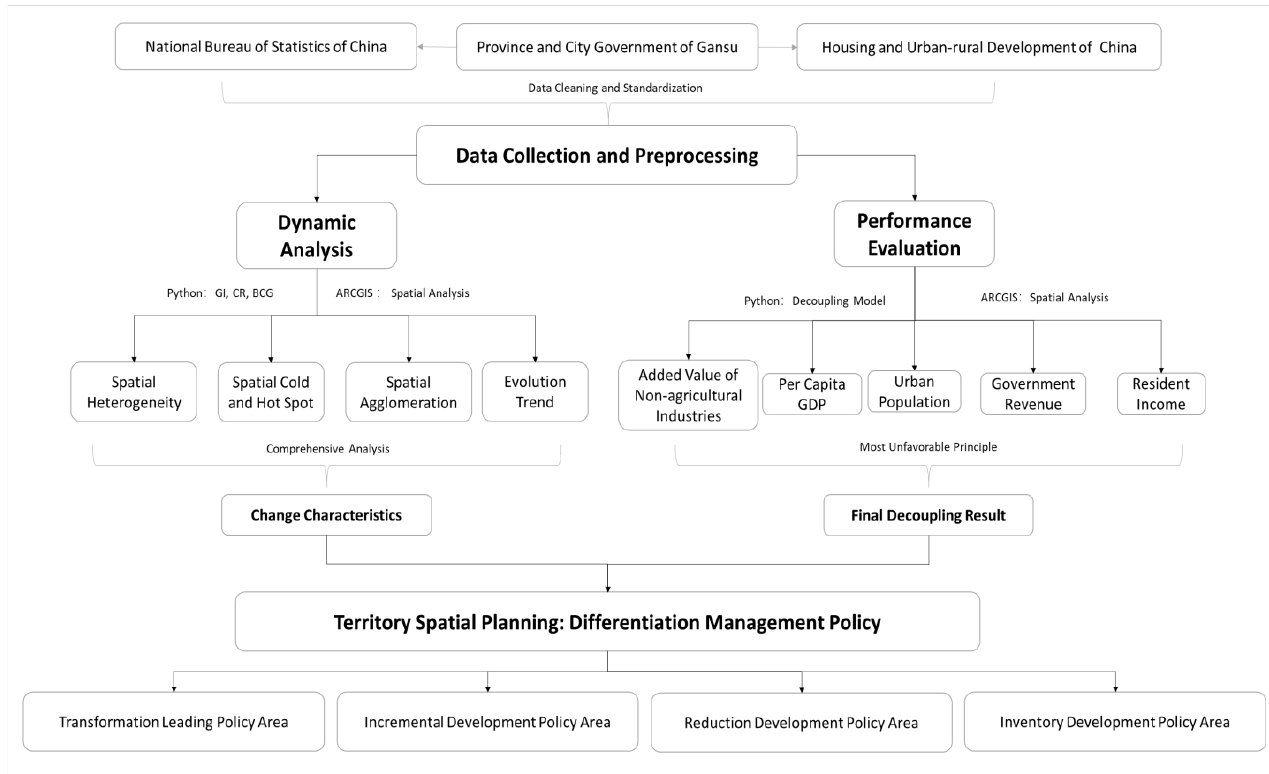
Figure 4. Research